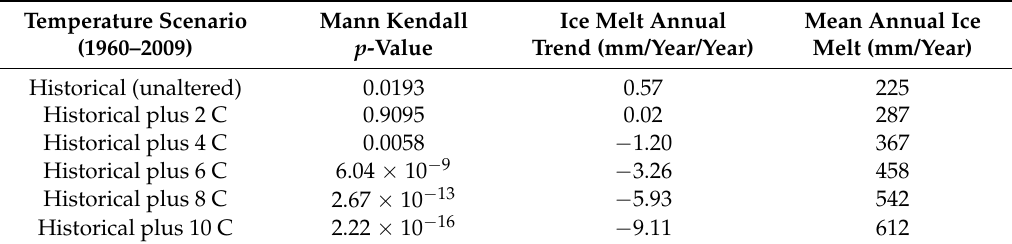
Table 6. Temperature sensitivity of annual runoff from melting glacier ice.